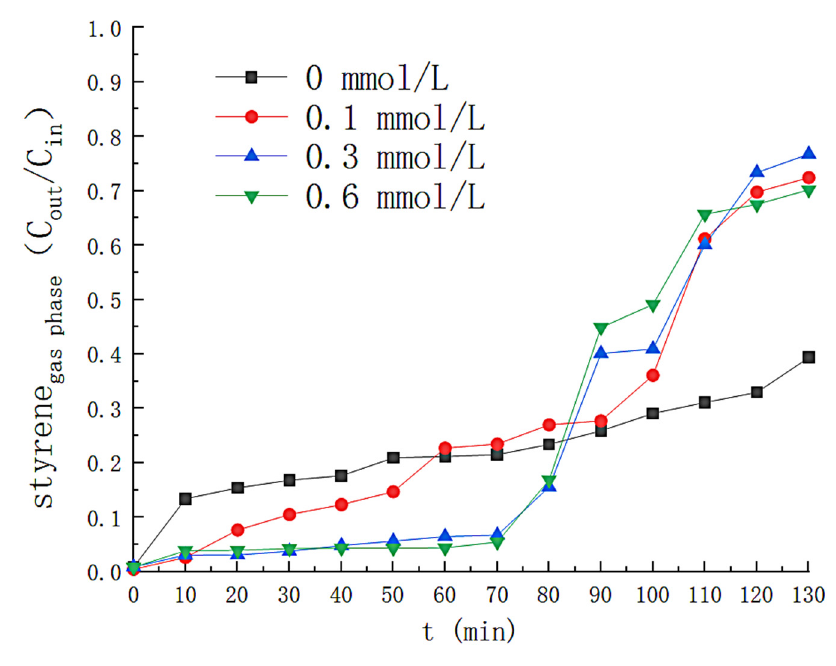
Figure 7. Effect of Fe 2+ concentration on removal efficiency of styrene.